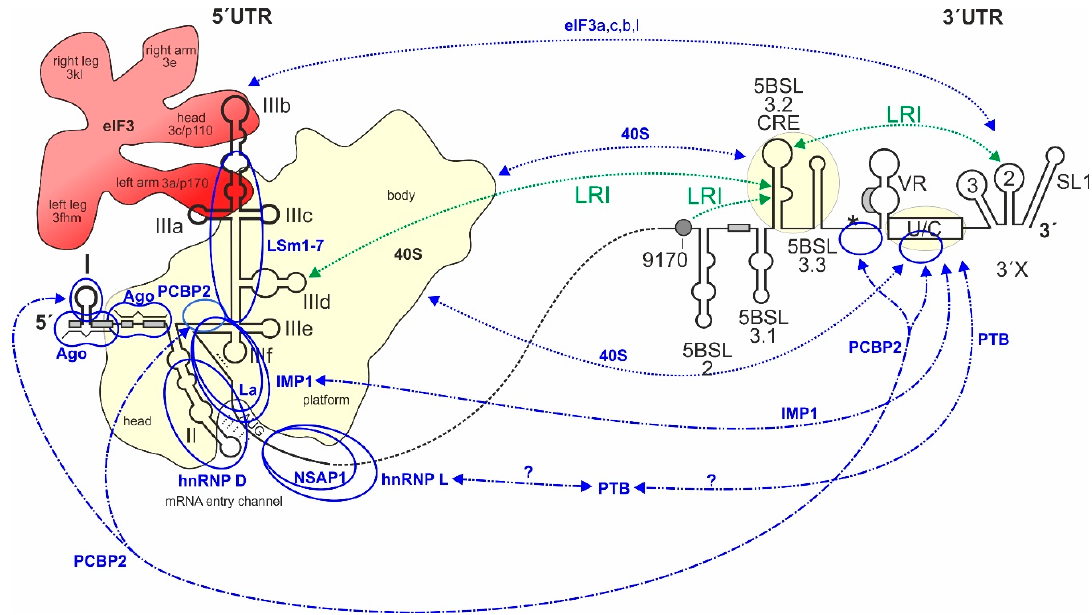
Figure 7. Interactions between HCV 5´- and 3´UTR. The HCV RNA is shown as a black line, with most of the coding region shortened as a dotted line. RNA–RNA long-range interactions (LRIs) are shown with green lines. Interactions mediated by proteins, by the 40S subunit, and by eIF3 are shown with blue lines. The proteins are shown as transparent bodies with blue lines. Other indications are as in previous figures. For details, please see main text.